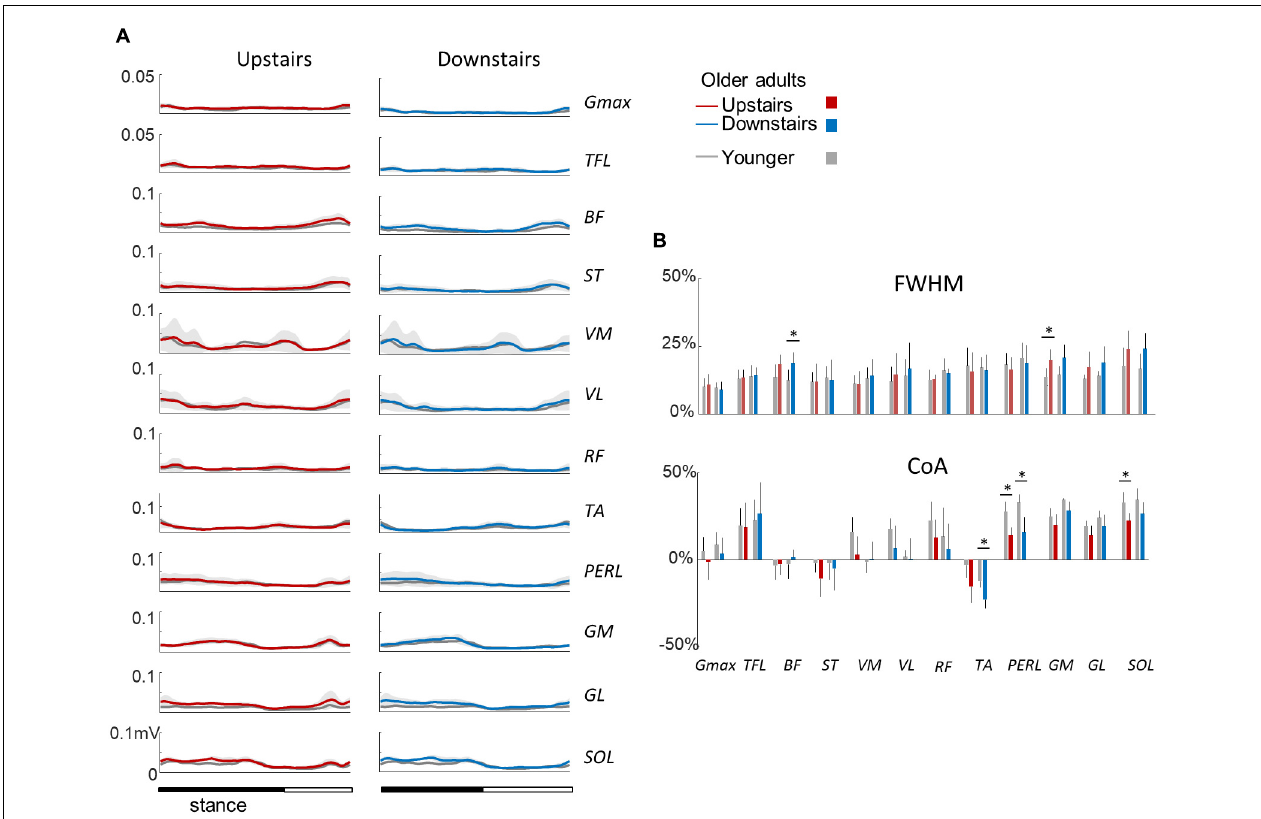
FIGURE 5 | Ensemble-averaged EMG patterns during upstairs and downstairs stepping in young and older adults. (A) Ensemble-averaged EMG patterns over one stride in upstairs (red) and downstairs (blue) stepping. (B) FWHM and CoA of the 12 lower-limb muscles during stair stepping. Other indications as in Figure 2